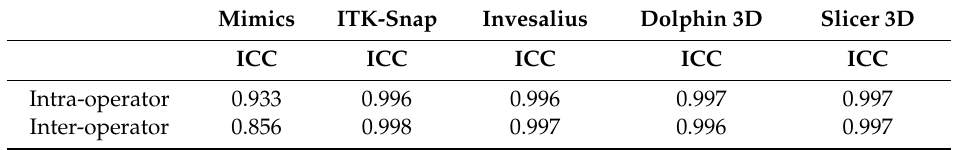
Table 6. Intra-operator and inter-operator reliability according to the intraclass correlation coe ffi cient